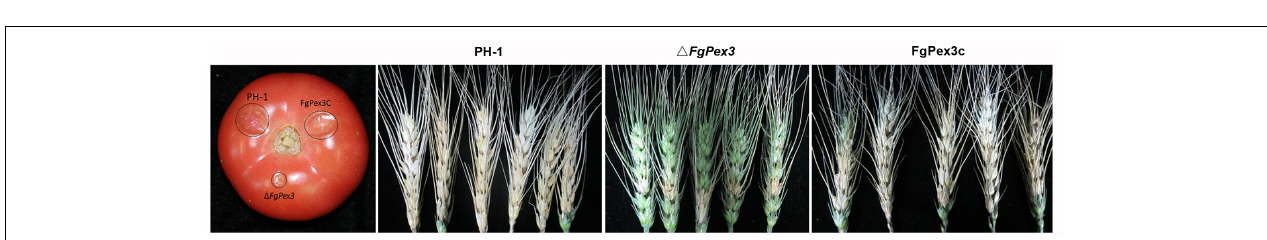
FIGURE 6 | Virulence of PH-1, (cid:49) FgPex3 and FgPex3C on infected plants. Virulence of the three strains was determined by point inoculations of conidial suspensions on five tomato fruits and 30 wheat heads. Infected tomato fruits and wheat heads were photographed at 3 days and 21 days post inoculation, respectively.